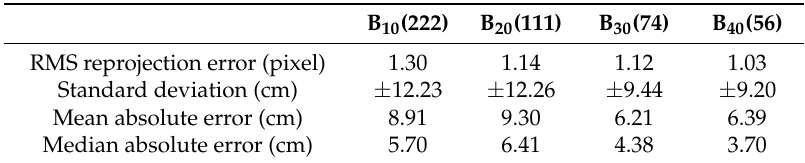
Table 2. Statistic results of the accuracy assessment of the Stupa with variable baselines. In the brackets of the first line are the number of frames.